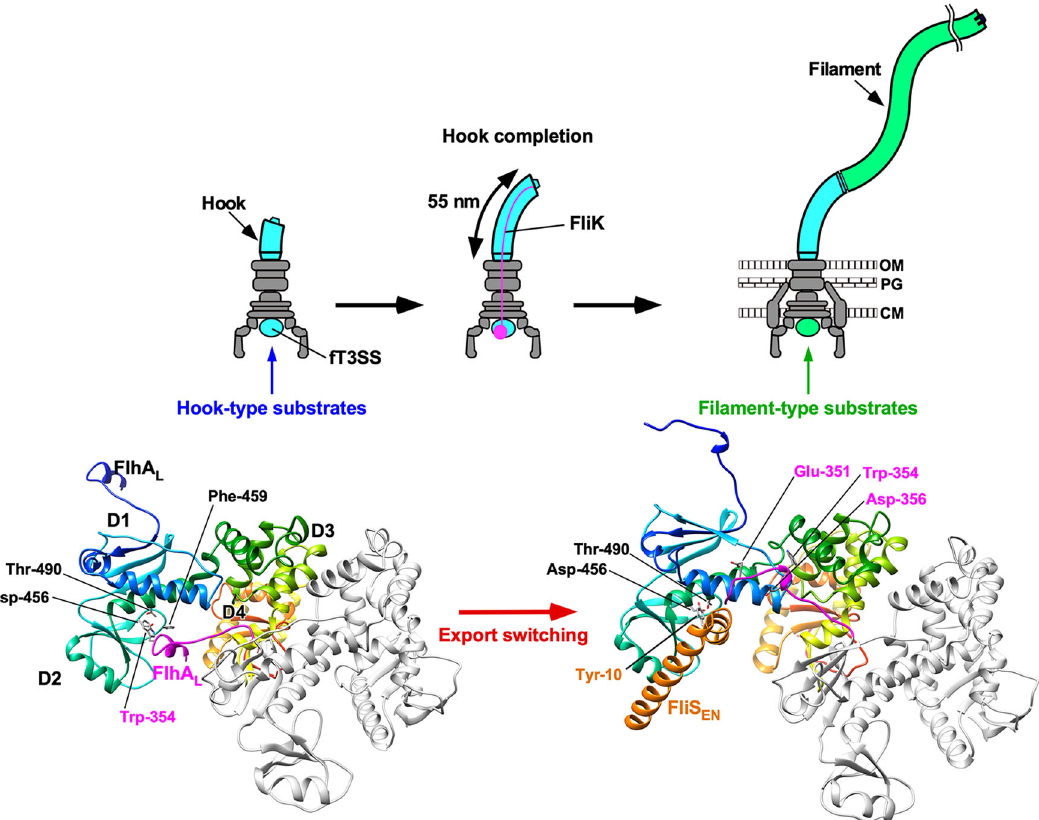
Fig. 8 Structural rearrangements of FlhA L responsible for export switching of fT3SS. Trp-354 of FlhA L binds to a well-conserved hydrophobic dimple containing Asp-456, Phe-459, and Thr-490 of its neighboring FlhA C subunit in the FlhA C ring not only to inhibit the interaction of FlhA C with fl agellar chaperones in complex with their cognate fi lament-type substrates but also to facilitate the export of the hook protein during hook assembly. When the hook reaches its mature length of about 55 nm, an interaction between FliK C and FlhB C triggers a conformational rearrangement of the FlhA C ring so that FlhA L dissociates from the hydrophobic dimple and binds to the D1 and D3 domains of the neighboring FlhA C subunit, allowing the chaperones to bind to FlhA C to facilitate the export of their cognate substrates for fi lament